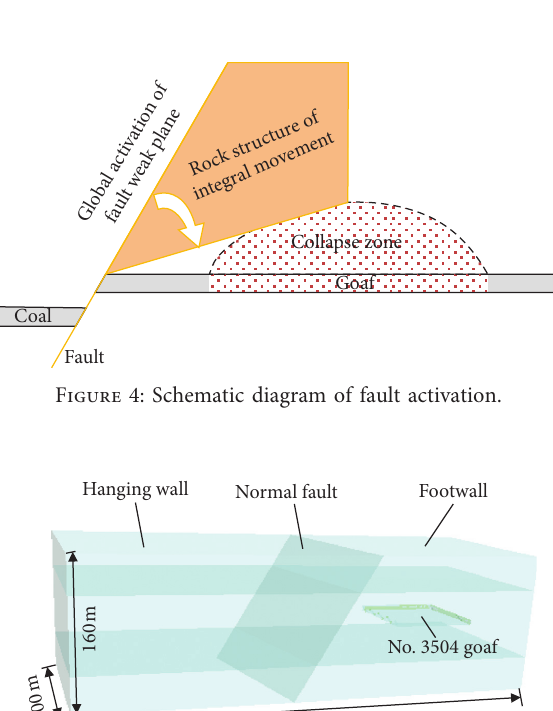
Figure 3: Height of fractured zone in overlying strata. x mining position of working face. h i is the height of overburden fracture when mining face reaches x i .